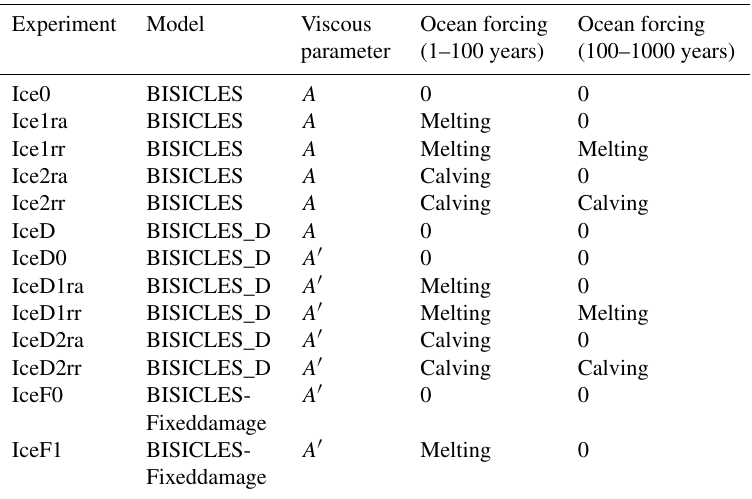
Table 1. Summary of simulations carried out in the current study. The entries in the first column correspond to MISMIP + experiment names (Asay-Davis et al.,